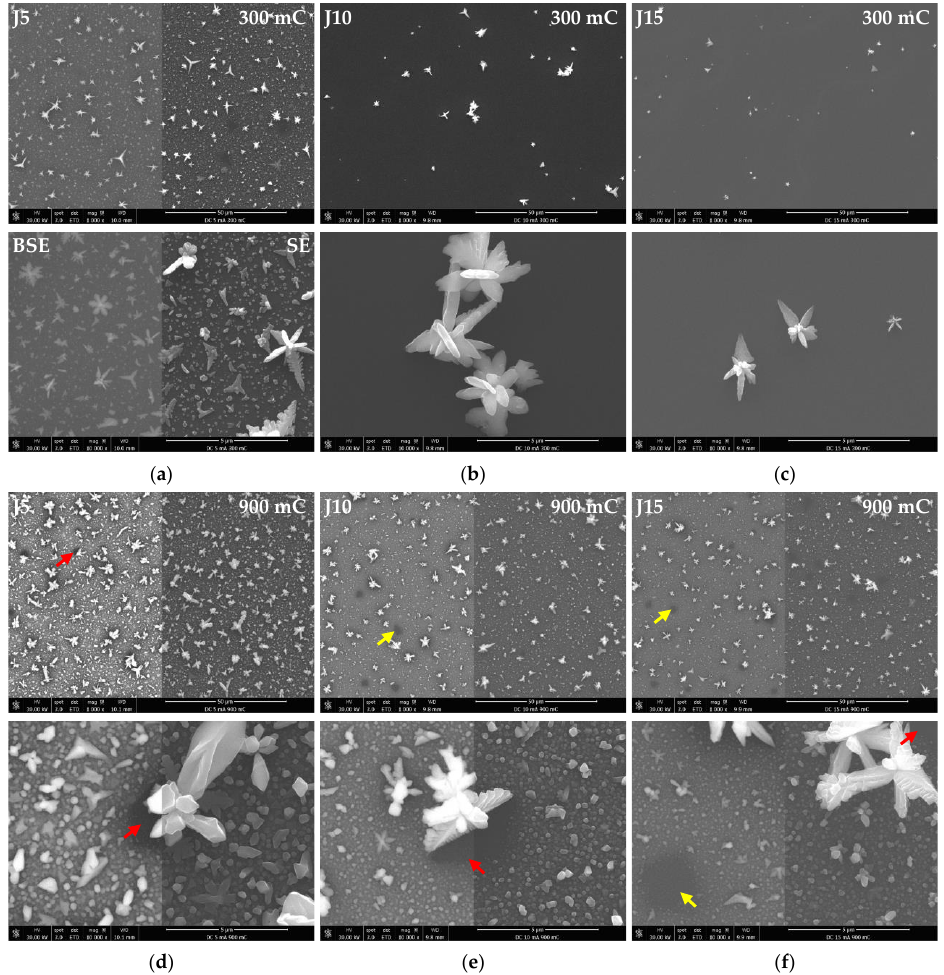
Figure 4. SEM images of the central regions of the as-deposited Cu films with current densities of 5 ( a ), 10 ( b ), 15 mA·cm −2 ( c ) for 300 mC and at the same current densities in ( d ), ( e ), and ( f ), respectively, for 900 mC, without electrolyte agitation. BSE images are overlaid on SE images in some of the figures.